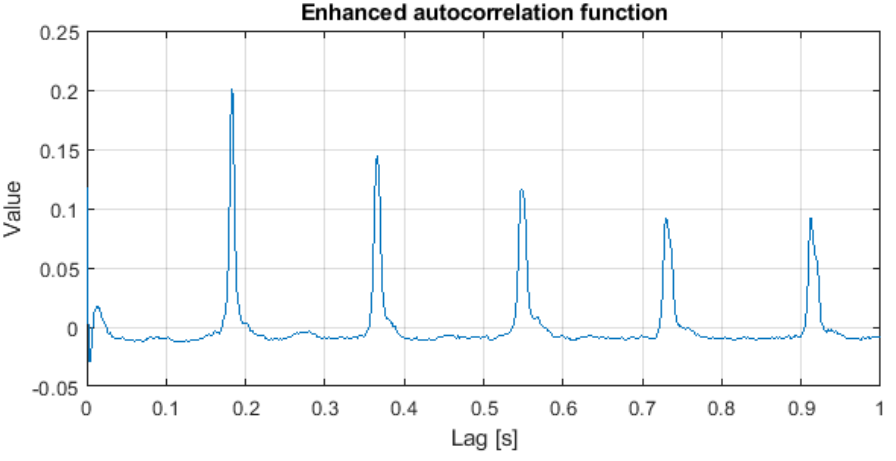
Figure 16. Enhanced autocorrelation